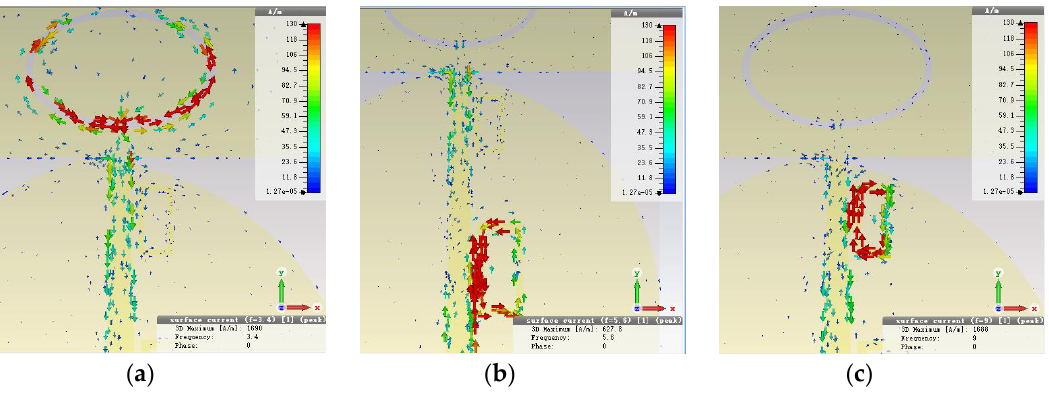
Figure 11. Current distribution at: ( a ) 3.4 GHz; ( b ) 5.6 GHz; ( c ) 9 GHz.